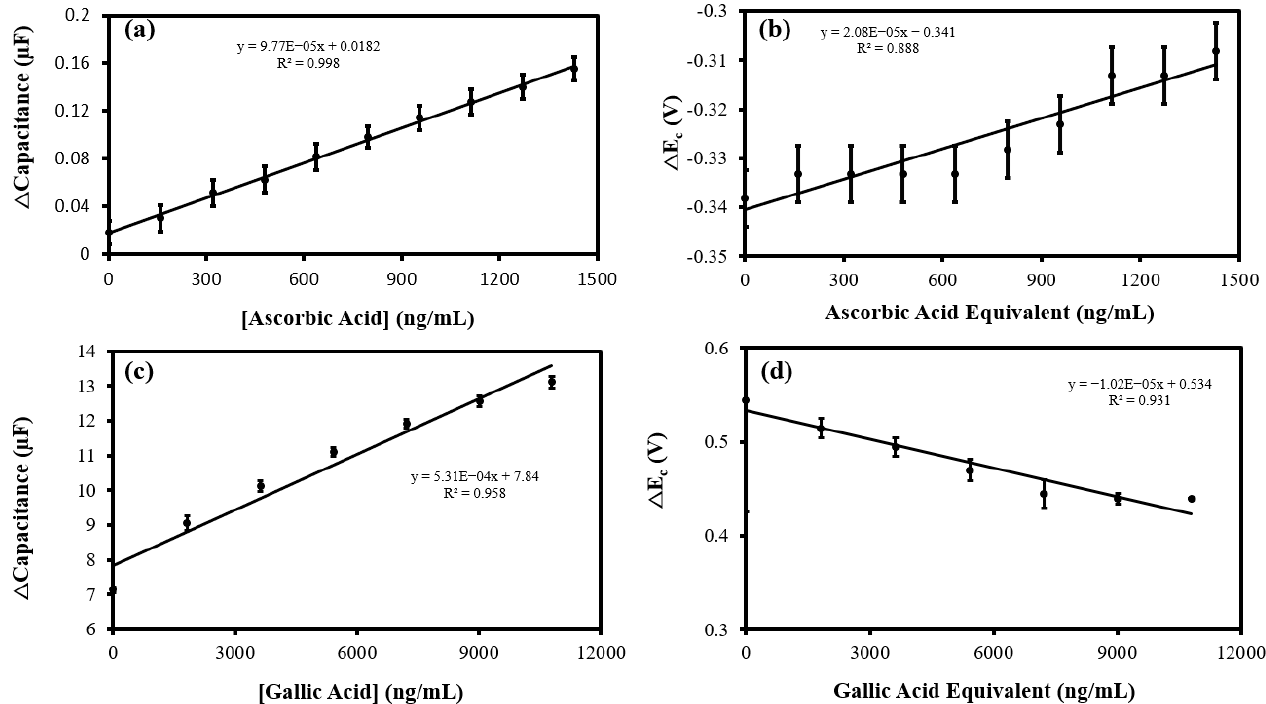
Figure 8. ( a ) Cathodic Δ capacitance; and ( b ) Δ E c vs. ascorbic acid concentration standard addition (SA) calibration plots of king mushroom sample analysis ( n = 3) using the MN redox sensor. ( c ) Cathodic Δ capacitance; and ( d ) Δ E c vs. gallic acid concentration SA calibration plots of brewed coffee sample analysis ( n = 3) using the MN redox sensor.